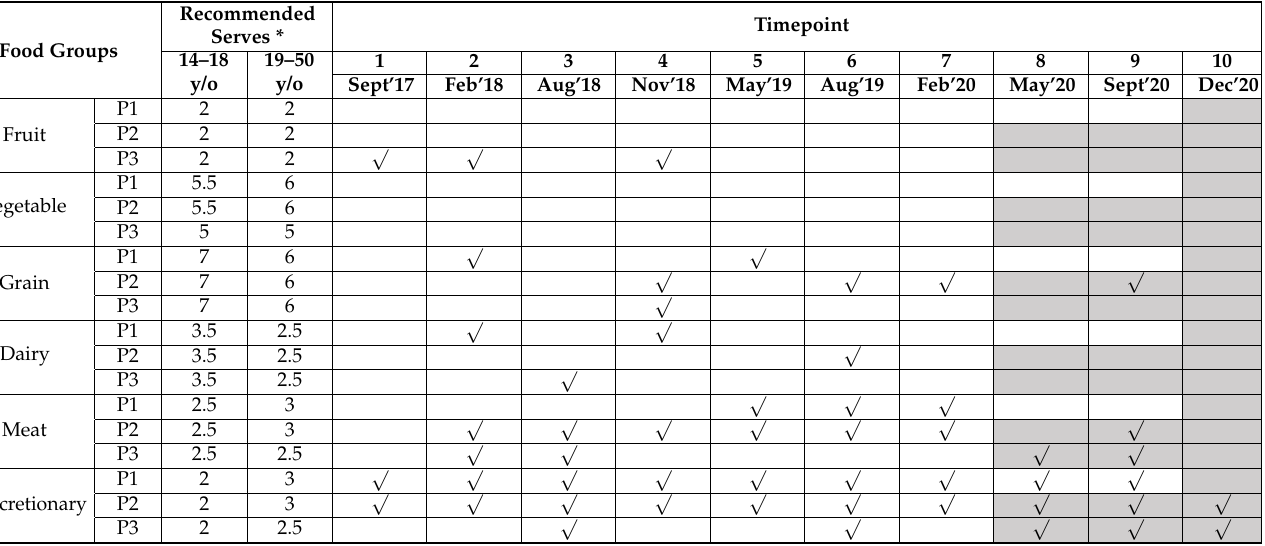
Table 2. Food group analysis for each participant over the data collection period by comparing adolescent data points to national adolescent recommendations, and adult data points to national adult